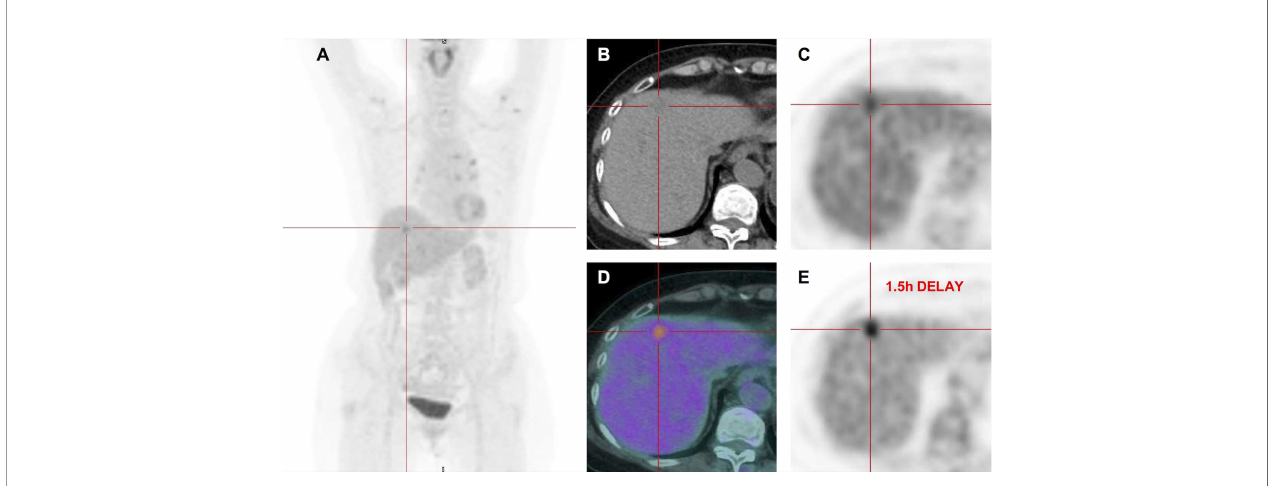
FIGURE 3 | 18 FDG PET-CT images. Maximum intensity projection PET (A) . Transverse CT (B) showed a slightly low-density lesion in segment 4 of liver. Corresponding PET (C) and fused (D) images showed increased FDG uptake with SUVmax of 4.81. Corresponding PET image (E) after 1.5 h delay showed